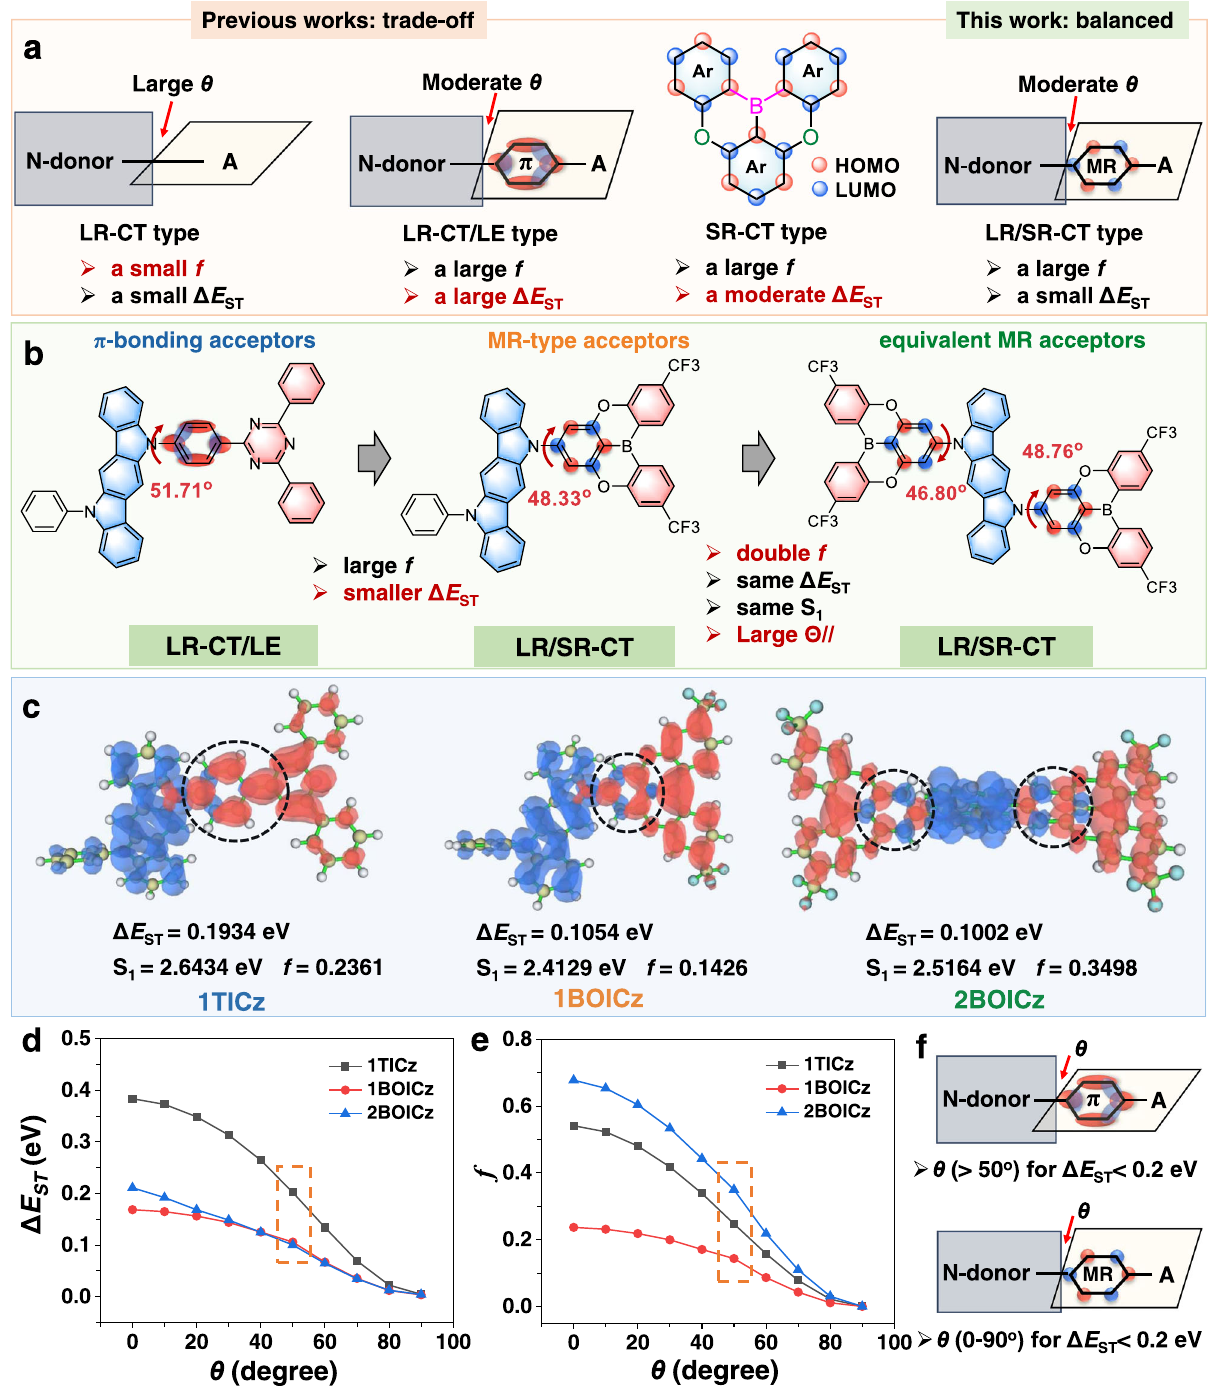
θ between donor and acceptor at the B3LYP/6-31G(d, p) level. The dashed box corresponds to θ of a DFT-optimized structure for three TADF emitters in the ground state. f Effect of the varied θ between donor and acceptor on Δ E ST for emitters with conventional acceptor and MR